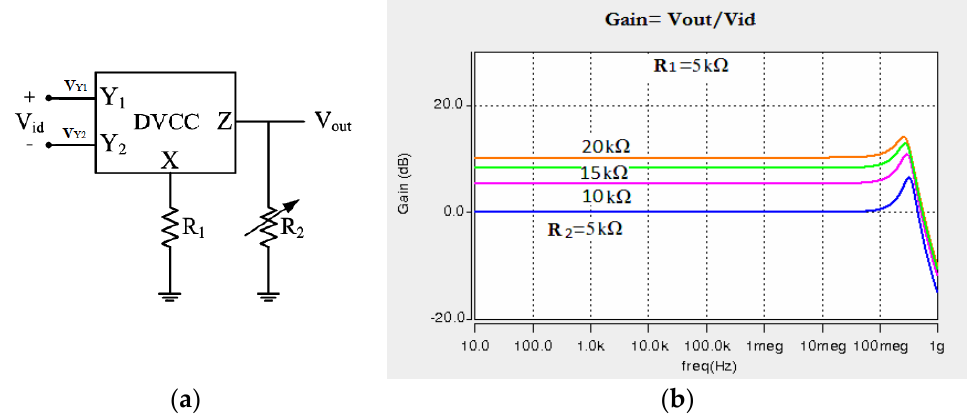
Figure 7. ( a ) The block diagram of the instrumentation amplifier implemented using the presented DVCC, ( b ) Voltage gains for different resistances at the output of this instrumentation amplifier.